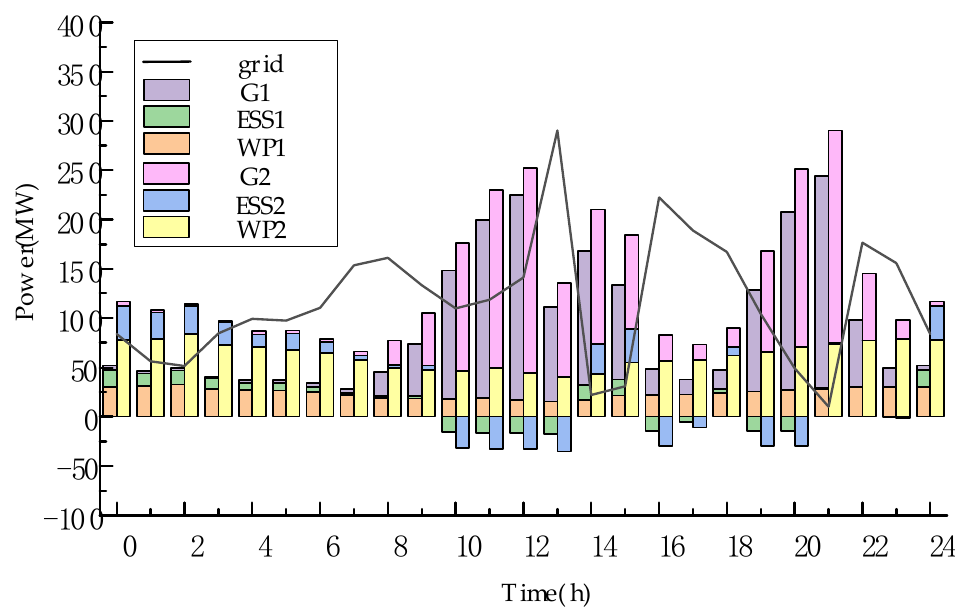
Figure 6. Power operation diagram under Scheme B.